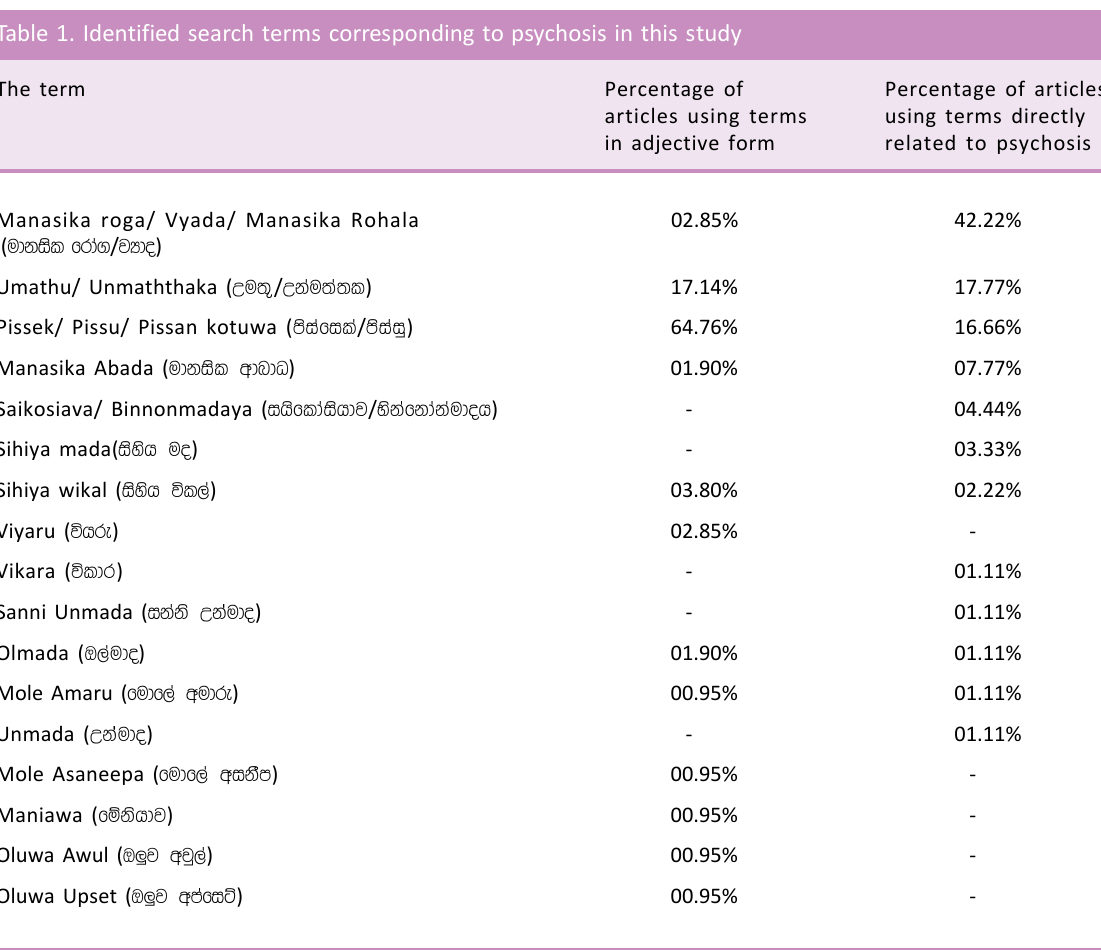
Table 1. Identified search terms corresponding to psychosis in this